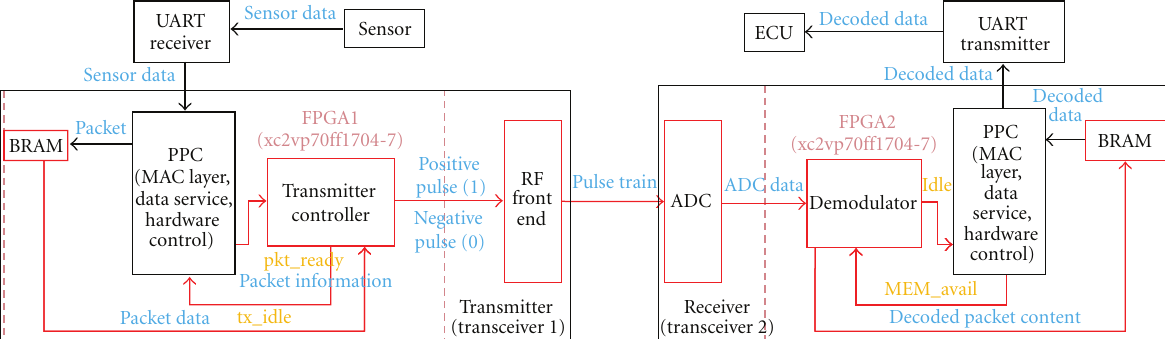
Figure 2: Transceiver block diagram.